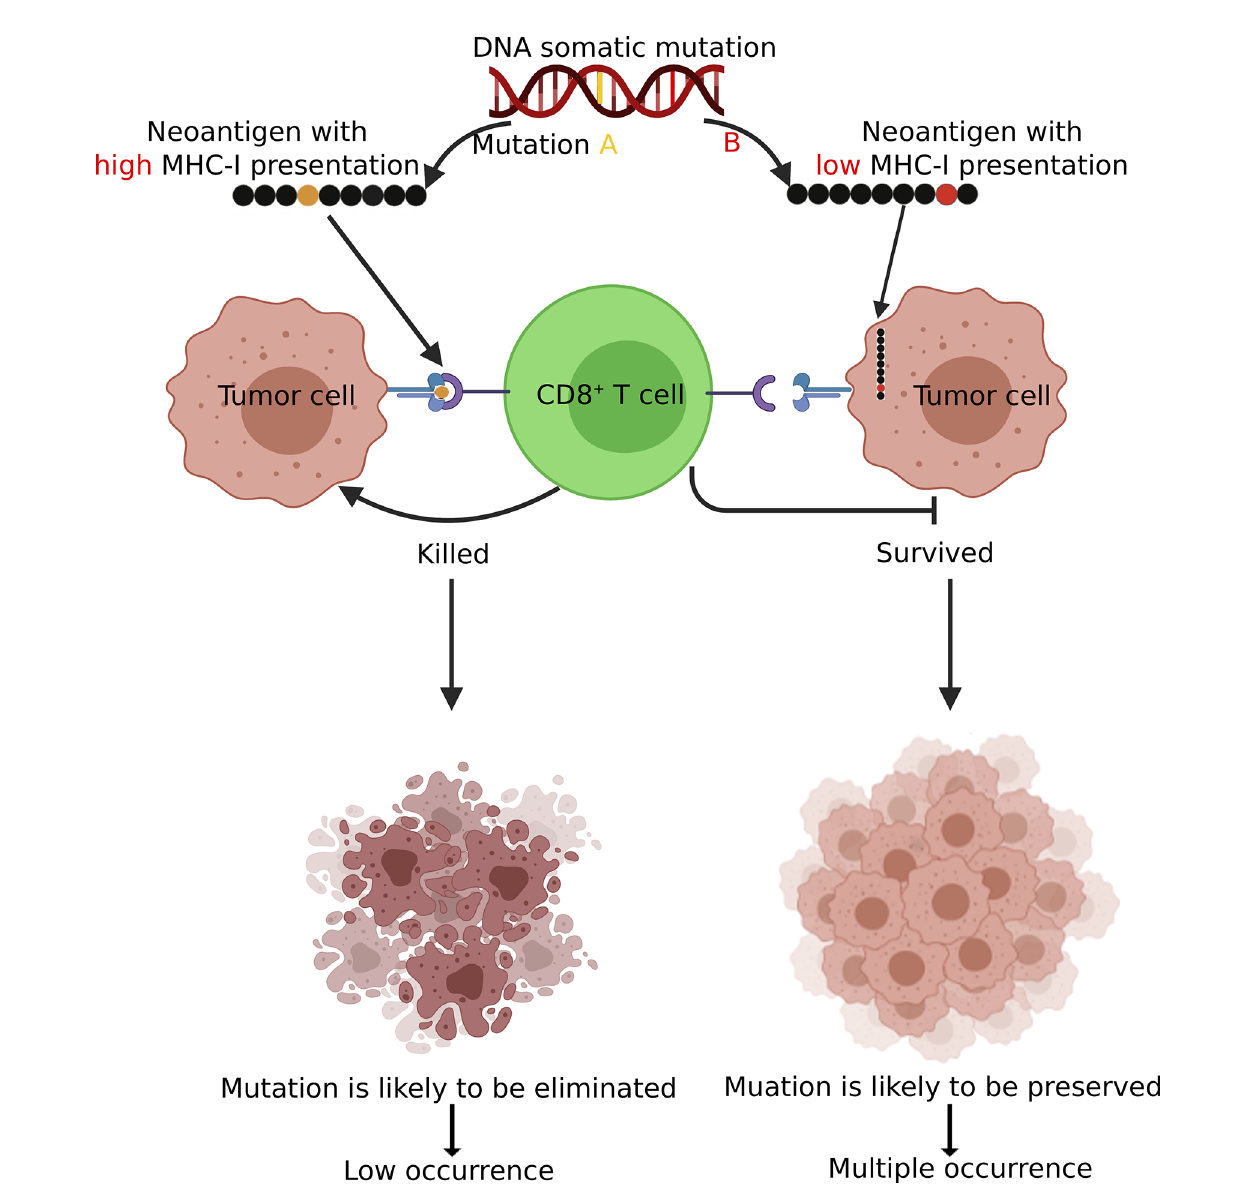
FIGURE 7 | A schematic diagram demonstrating how immunosurveillance shapes the somatic mutation landscape in tumors. Somatic mutations leading to CD8+ neoantigen with high MHC-I binding af fi nity are more likely to be recognized and eliminated by T cells and there tend to have low occurrences (non-recurrent) in tumor. In contrast, mutations with low MHC-I binding af fi nity are more likely to be preserved and present in multiple patients. Figure created using BioRender (https://